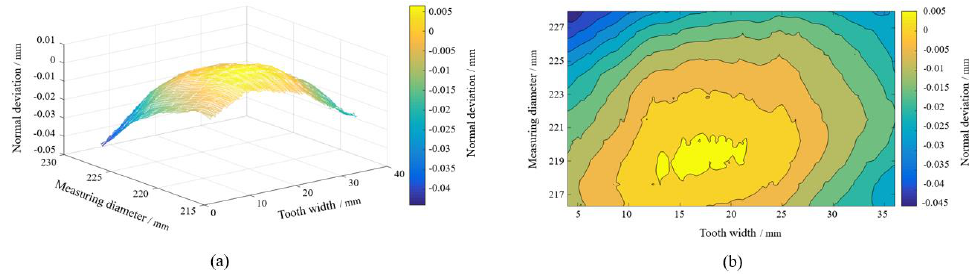
Figure 9. 3D normal deviations of the right tooth surface of the first tooth: ( a ) 3D topological error; ( b ) error contour map.